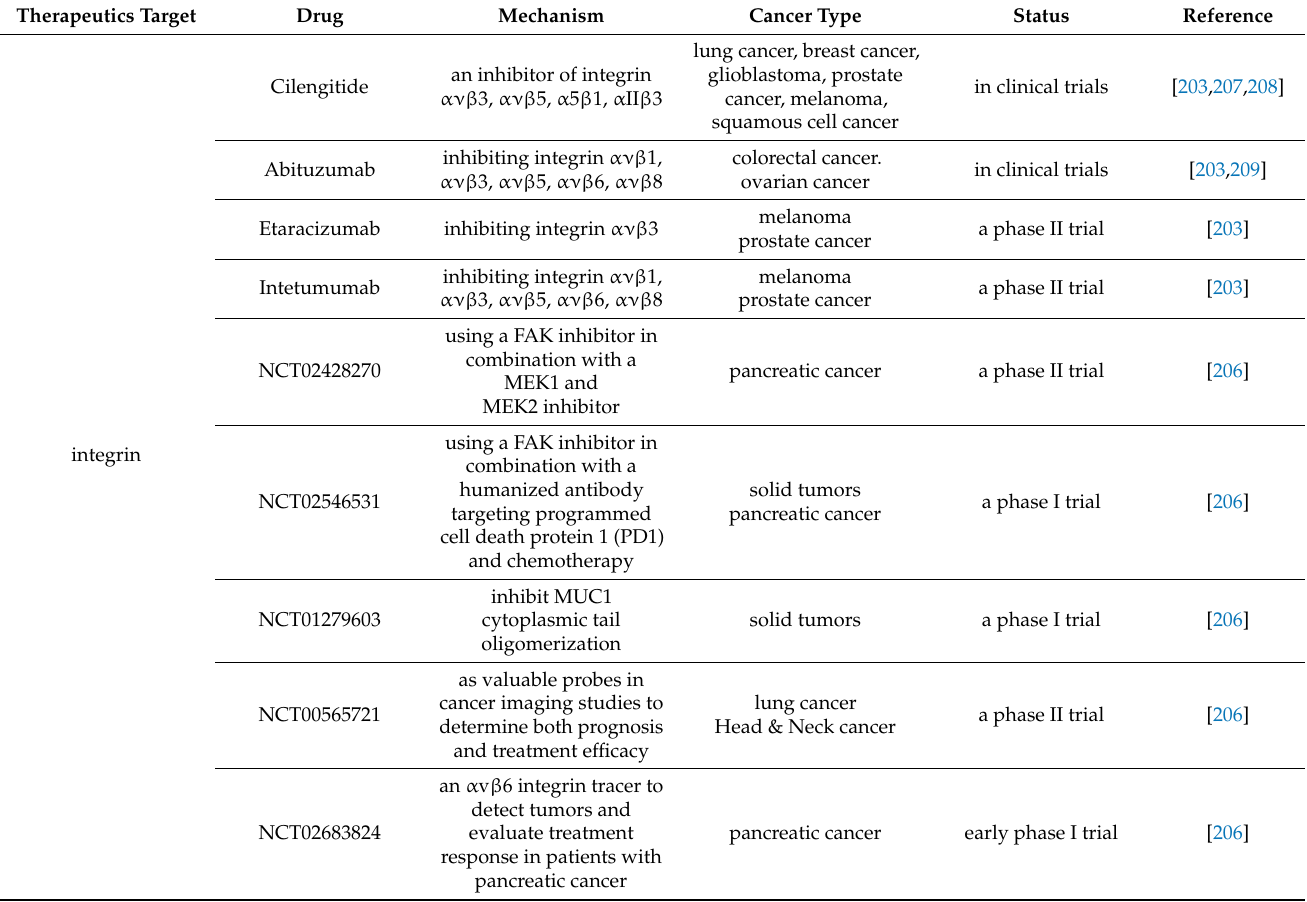
Table 3. Integrin-associated therapy and the related drugs in cancer therapeutics. Therapeutics